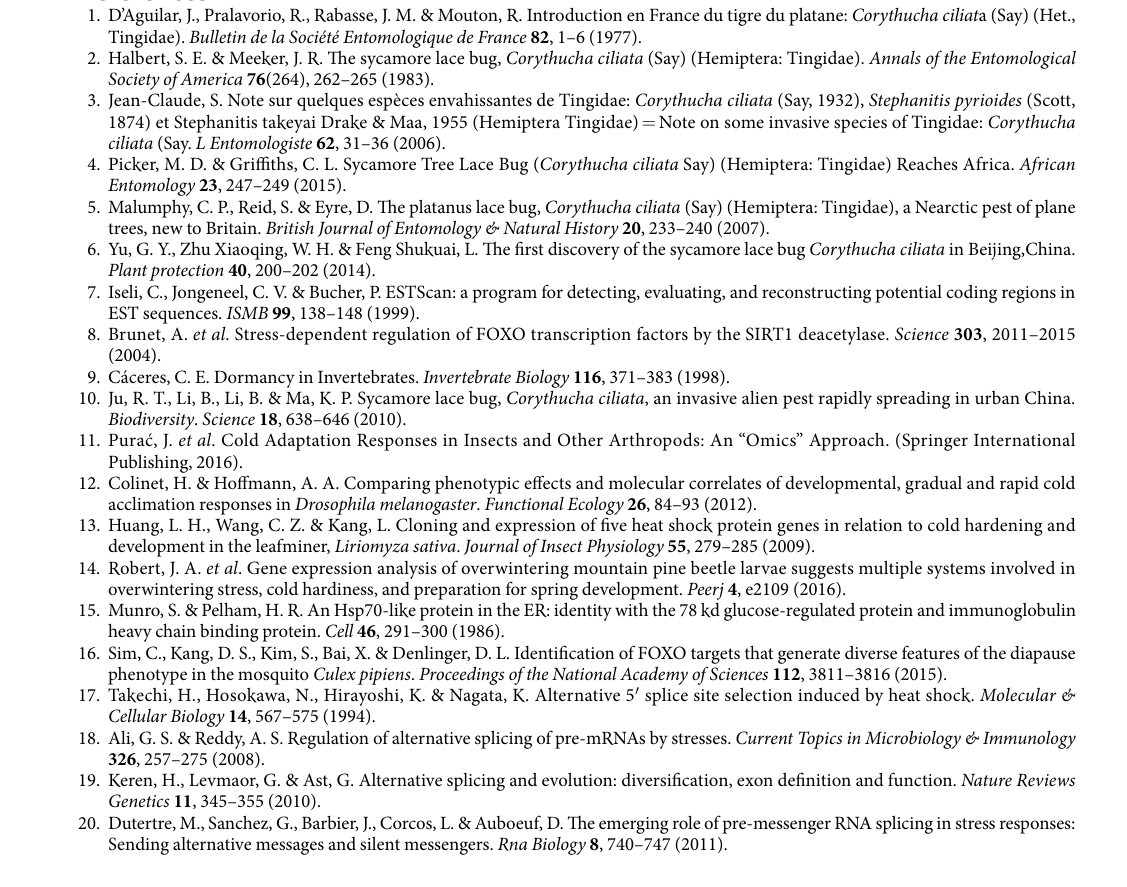
loss during extraction or injection. Metabolite contents were log2 transformed before analysis. Metabolite quan- tities were compared across the different treatments using ANOVA and Student’s t -test in IBM SPSS Statistics software 20. The metabolic and transcriptomic data were integrated by mapping the Drosophila melanogaster and Acyrthosiphon pisum biochemical pathways based on KEGG. qRT-PCR. Table S3. The reactions were performed using the 2 × GoTaq ® qPCR Master Mix (Promega, Madison, WI, USA) and all reactions were conducted using the ABI Prism ® 7500 (Applied Biosystems, Carlsbad, CA, USA) with the following PCR-cycling conditions: 95 °C for 2 min; followed by 40 cycles of 95 °C for 30 s, 60 °C for 1 min; then a final melting cycle at 95 °C for 15 s, 60 °C for 15 s, 95 °C for 15 s. Relative RNA expression was normalized to the level of alpha-tubulin. All samples had three biological replicates with three technical replicates. Relative expres- sion levels of genes were quantified using the comparative 2 −ΔΔ Ct method 39 . The C. ciliata samples that were collected on September 17 (18 °C to 27 °C) and November 26, 2015 ( − 8 °C to 0 °C) were used for qRT-PCR. In addition, the samples collected on January 21, 2016 ( − 15 °C to − 26 °C) were used to further verify the transcript by